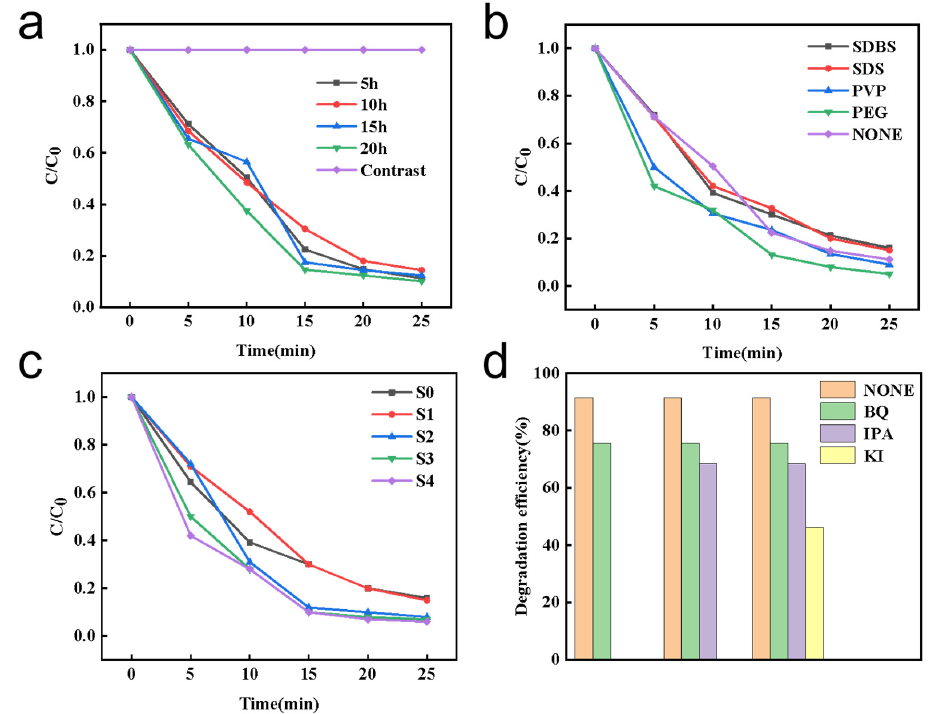
Figure 4. The photocatalytic efficiency of SnO 2 samples by ( a ) different solvothermal time, ( b ) different surfactants and ( c ) different F doping ratios. ( d ) Effects of Rh B degradation by different trapping on F-doped SnO 2 .